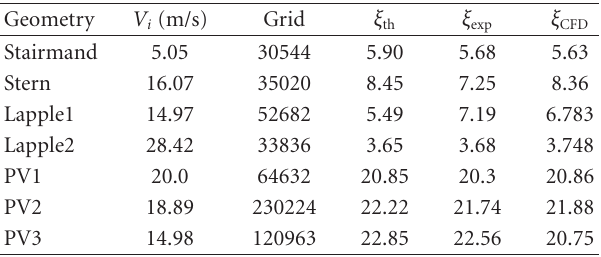
Table 2: Pressure drop coe ffi cient for pure gas. Table 3: Pressure drop coe ffi cient for di ff erent temperatures (Case PV1 of Table